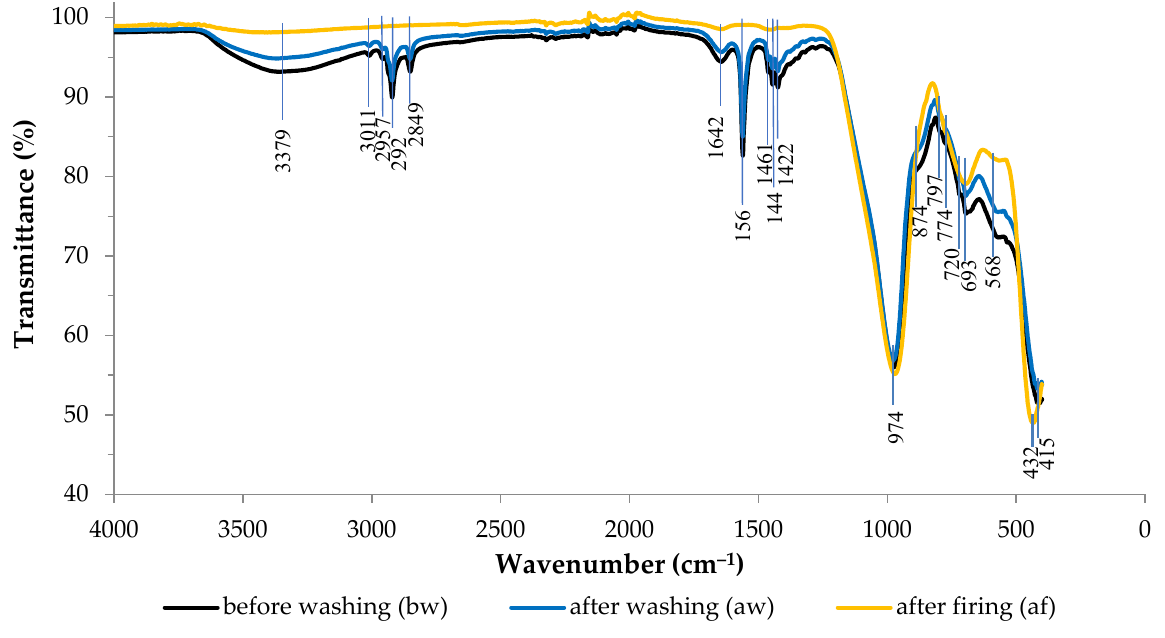
Figure 4. FTIR spectra of unwashed, washed and fired samples of S-4.5.